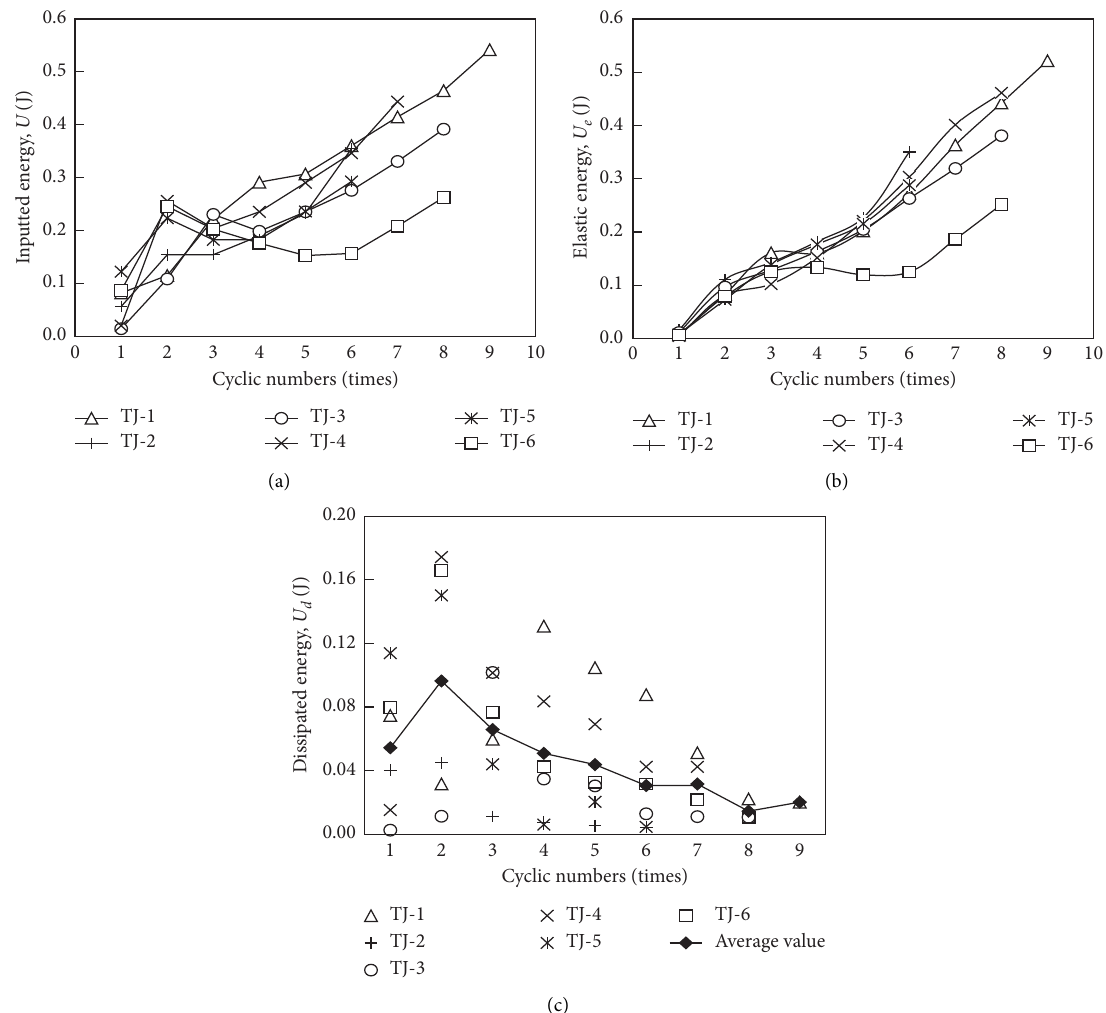
Figure 14: Energy evolution with tiered cyclic numbers. (a) Inputted energy, U . (b) Elastic energy, U